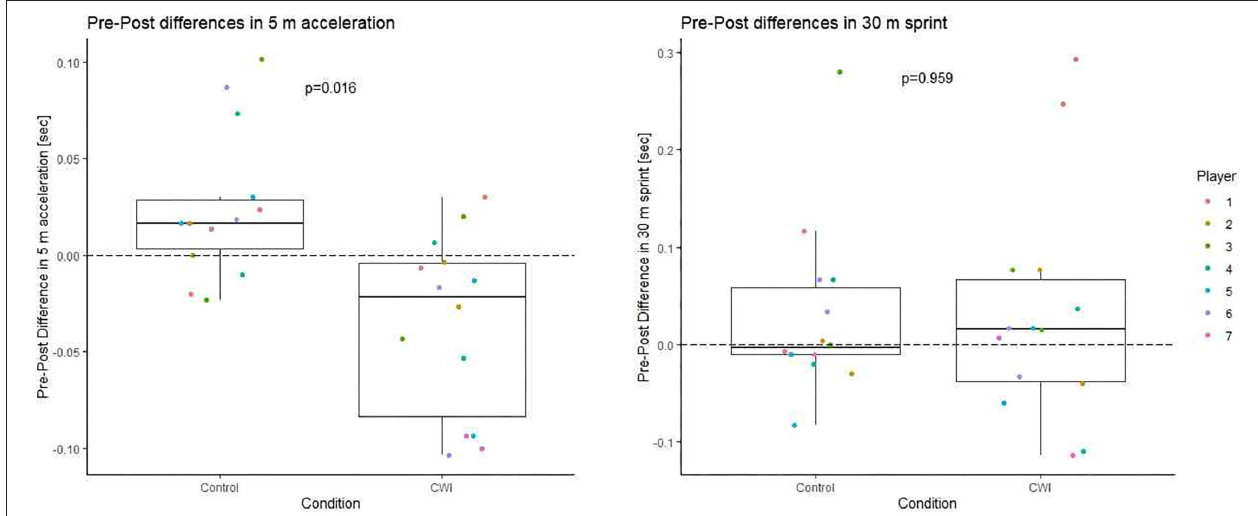
FIGURE 2 | Difference between conditions for 30m sprint and initial 5m section. Dashed lines highlight zero difference between conditions.